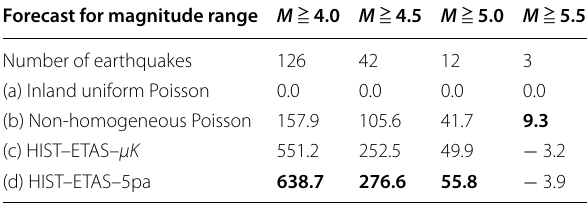
Assuming the G–R law with b 0.9 nationwide in Japan, these are the score = values of the forecasting of earthquakes of respective magnitude ranges; scores are relative to those of the “inland uniform Poisson model.”